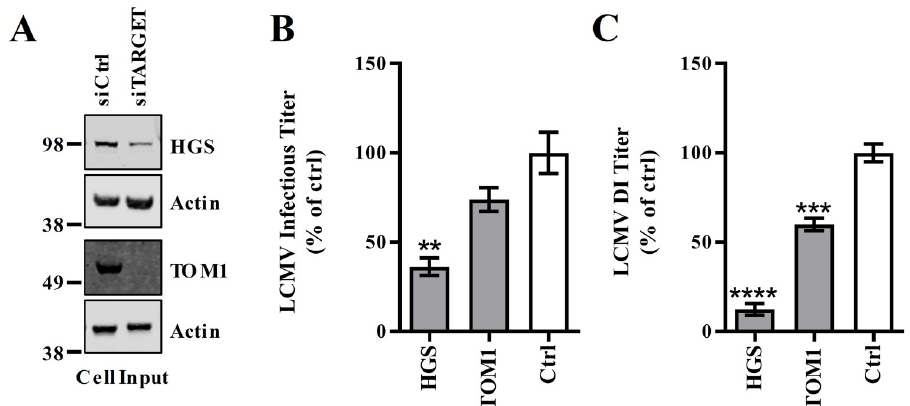
Fig 5. The ubiquitin-binding, ESCRT-0 protein HGS is required during mammarenavirus infection. (A-C) Human lung carcinoma (A549) cells were reverse transfected with small interfering (si)RNAs to the indicated targets or a non-targeting control siRNA and then two days later were infected with LCMV and cells and virus-containing cell culture media were collected after an additional two days. (A) Expression of siRNA-targeted proteins and actin was measured in cells by western blot. Infectious titers were determined by plaque assay (B) and LCMV DI particle titers were measured by plaque interfering assay (C). Data represent the mean ± SEM of three independent experiments. A one-way ANOVA with Holm-Sidak’s test for multiple comparisons was used to compare the mean values to the control siRNA in (B-D). �� p < 0.01, ��� p < 0.001, ���� p < 0.0001.